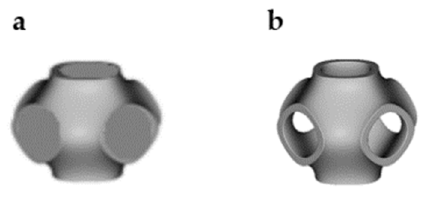
Figure 4. Schwarz primitive unit cell CAD model without ( a ) and with ( b ) thickness, respectively.